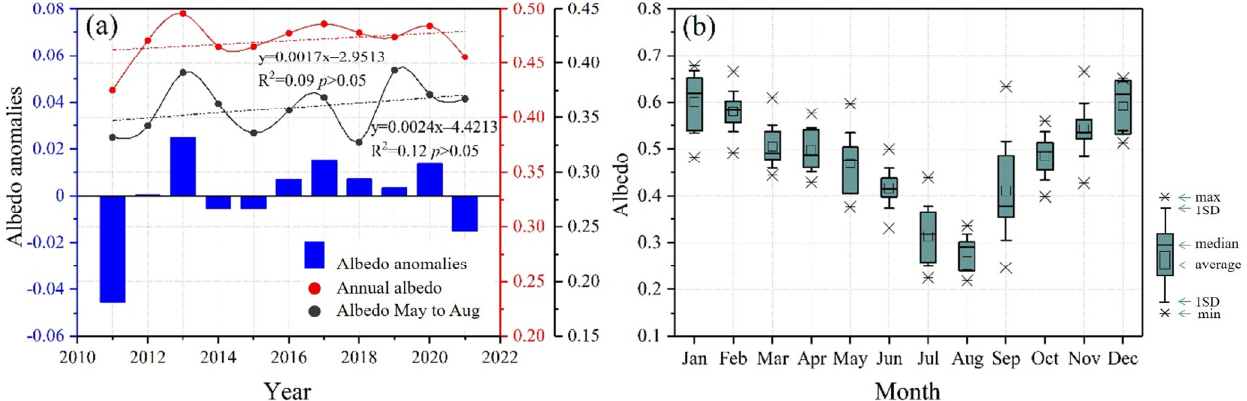
Figure 2. The annual ( a ) and the seasonal variation ( b ) in surface albedo on the Muz Taw Glacier during 2011-2021. The blue bars represent the annual average glacier surface albedo anomalies. The red and black dots indicate the annual average glacier surface albedo and the surface albedo during ablation period (May to August), respectively, and the dotted line represents linear trend.